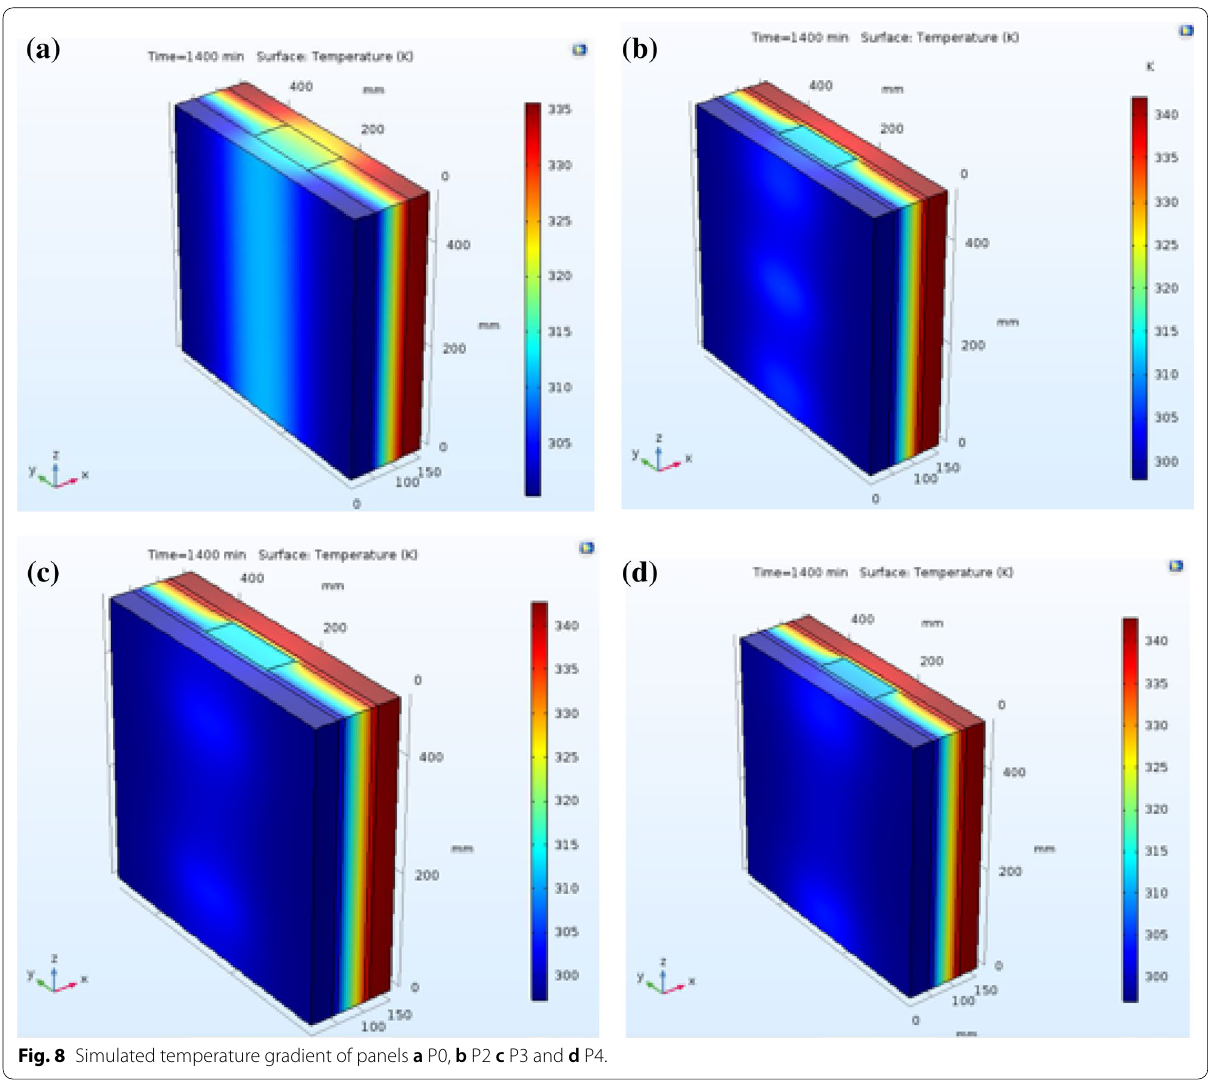
Fig. 8 Simulated temperature gradient of panels a P0, b P2 c P3 and d P4.